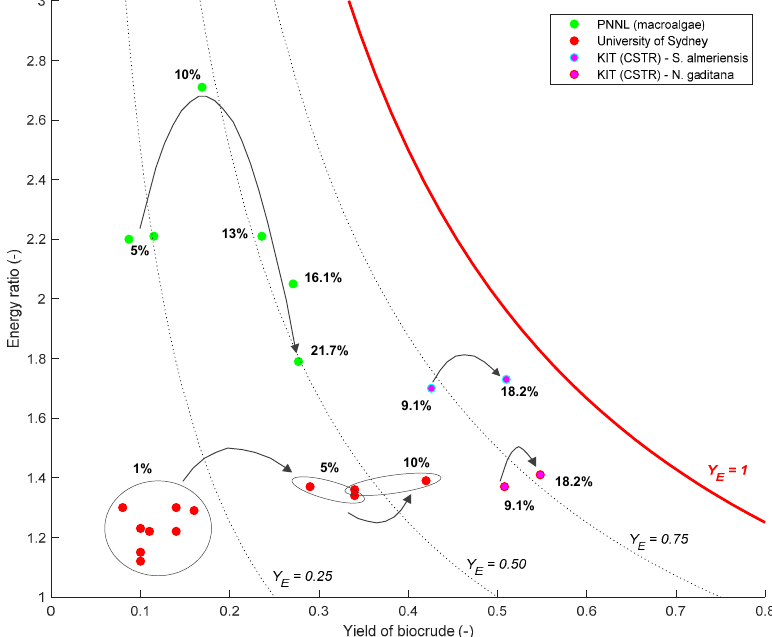
Figure 8. Effect of dry matter concentration on the energy ratio and bio-crude yields for the continuous HTL studies in the open literature. Percentages indicate the dry matter concentration of biomass in the feed.